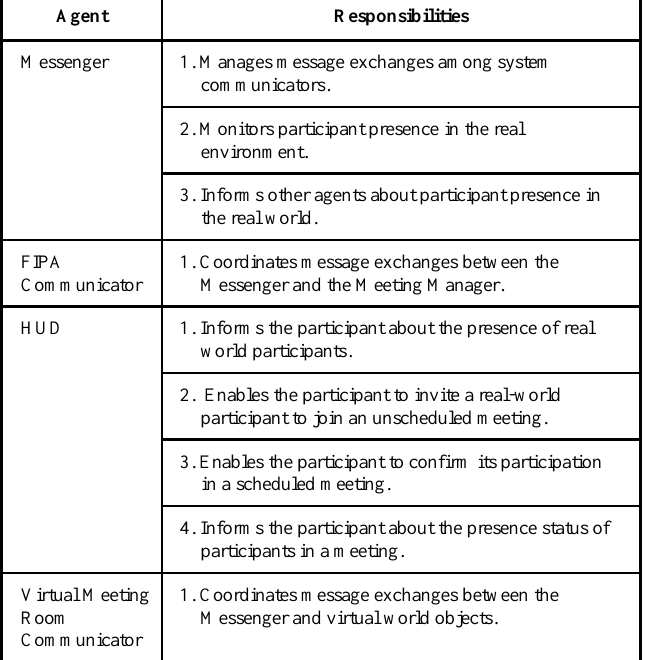
TABLE I. A GENT R ESPONSIBILITIES